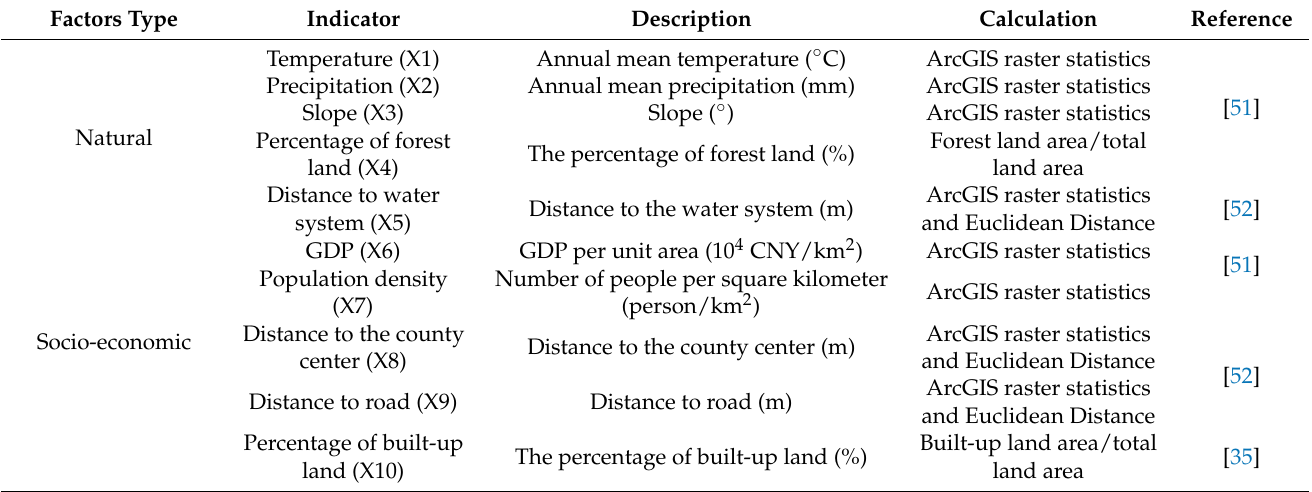
Table 3. Details of the driving